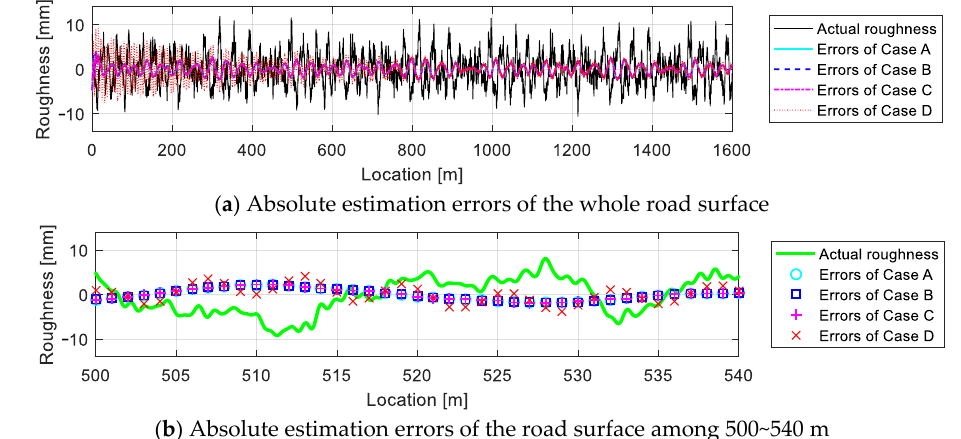
Figure 22. Absolute estimation errors of road roughness in Case A – Case D using direct estimation.